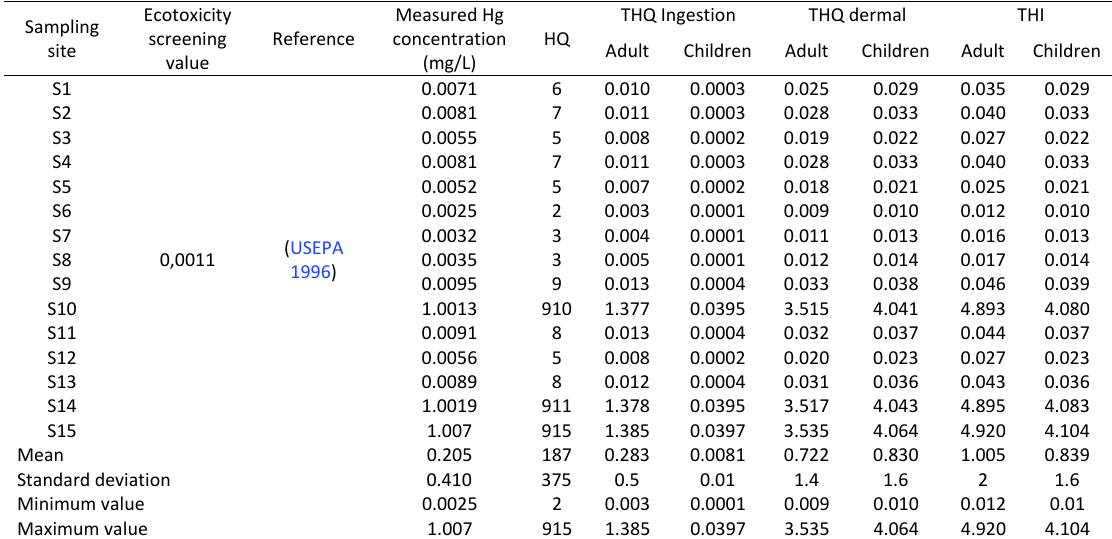
Table 2: Water Hg concentration, ecological risk (HQ), and human health risk (THQ and THI) of the Makassar coastal community Sampling